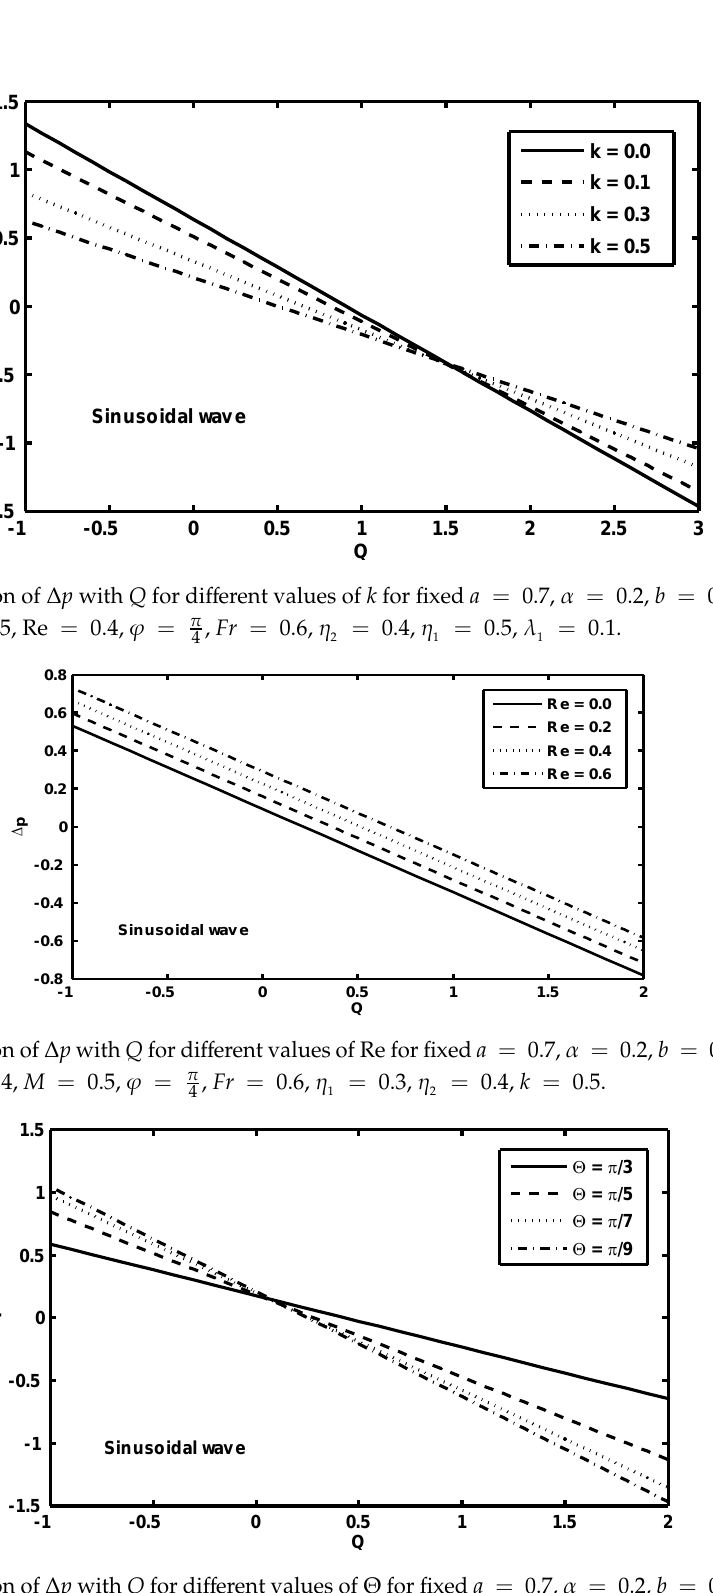
Figure 4. Variation of ∆ p with Q for di ff erent values of Θ for fixed a = 0.7, α = 0.2, b = 0.7, d = Fig. 4